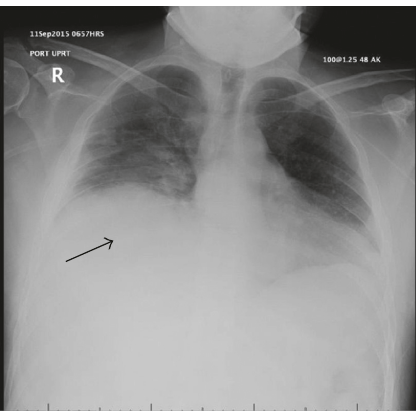
Figure 1: Chest X-ray shows a moderate-sized right pleural ef- fusion (arrow), which was later confirmed to be a hemothorax.